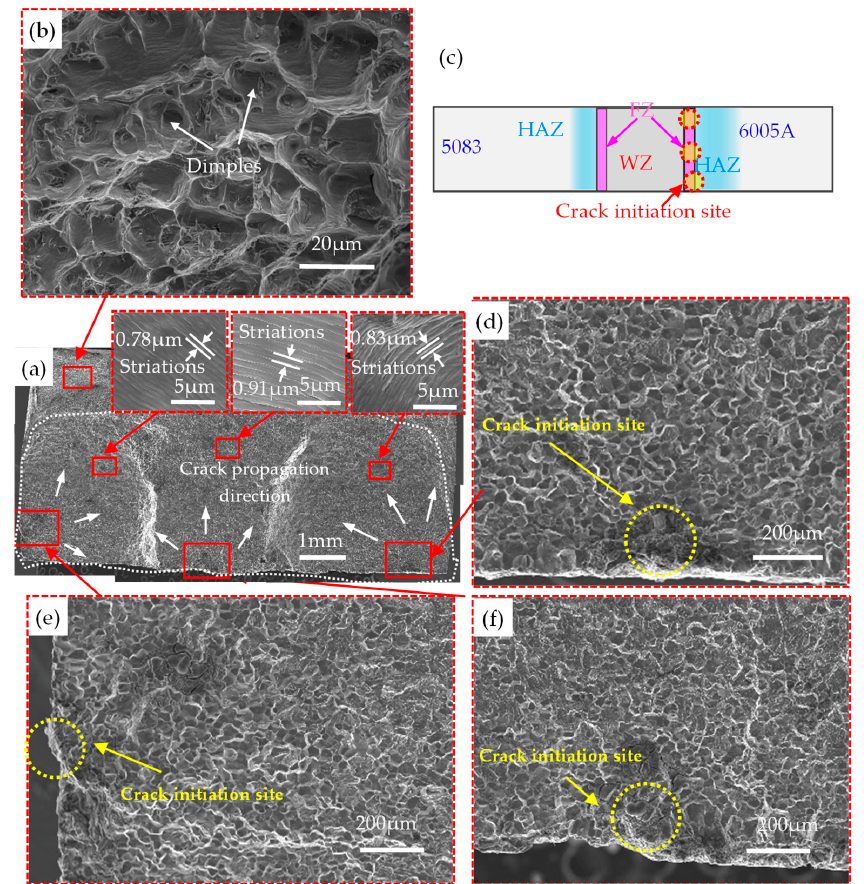
Figure 7. SEM images of fatigue fracture of the 5083/6005A welded joints corroded for 30 days: ( a ) overall fracture diagram; ( b ) dimples; ( c ) fracture location diagram; ( d ) crack source 1; ( e ) crack source 2; ( f ) crack source 3.